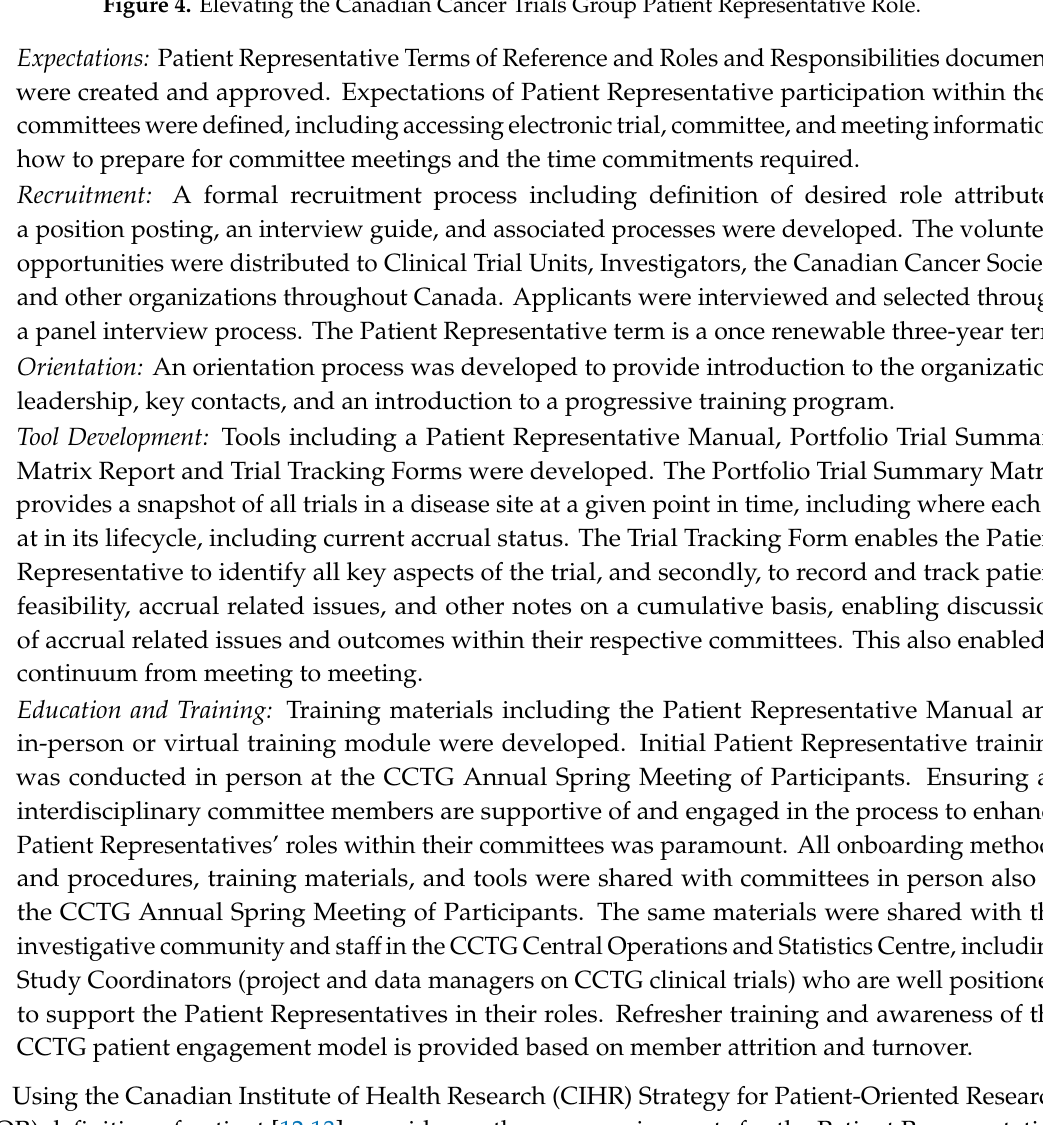
Figure 4. Elevating the Canadian Cancer Trials Group Patient Representative Role.